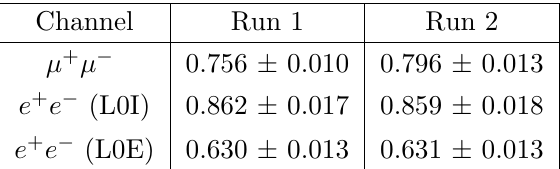
! pK (cid:0) ‘ + ‘ (cid:0) ) =(cid:15) ( (cid:3) 0 ! b b